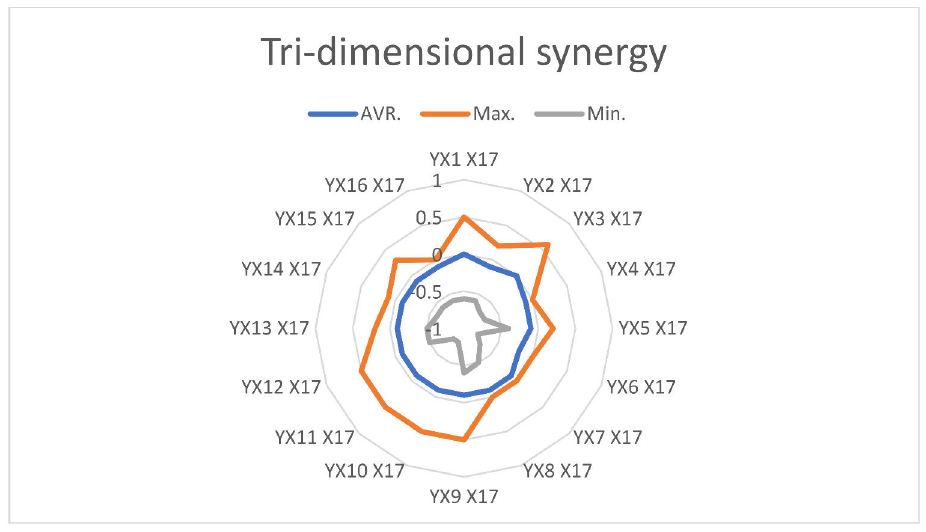
Figure 9. Tri-dimensional synergies in rapport with air emissions intensity of industry (X 17 ). Source: Authors’ representation.